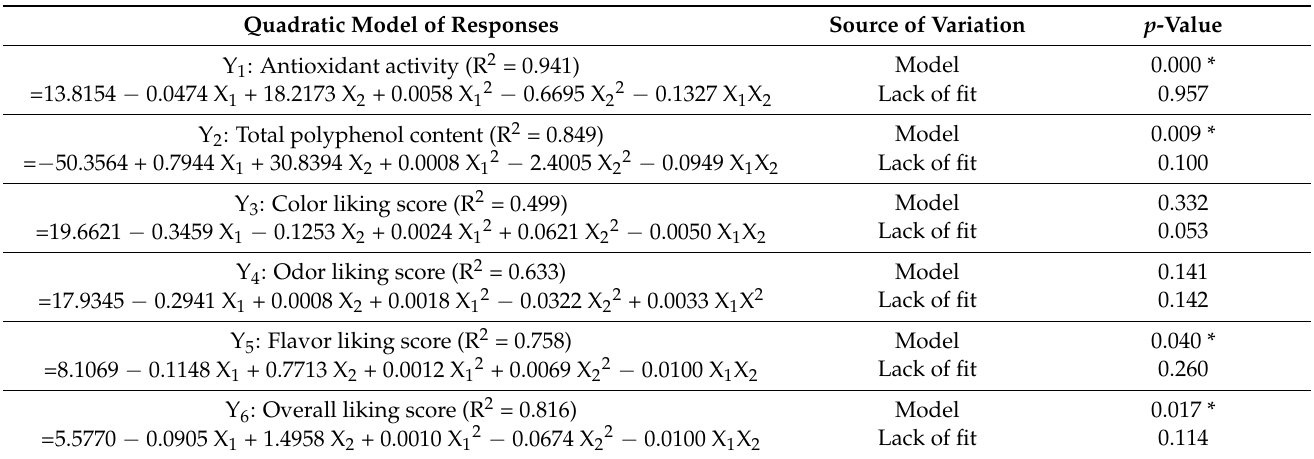
Table 3. ANOVA (analysis of variance) for the surface quadratic model for antioxidant activity, total polyphenol content, and liking score of sensory attributes.